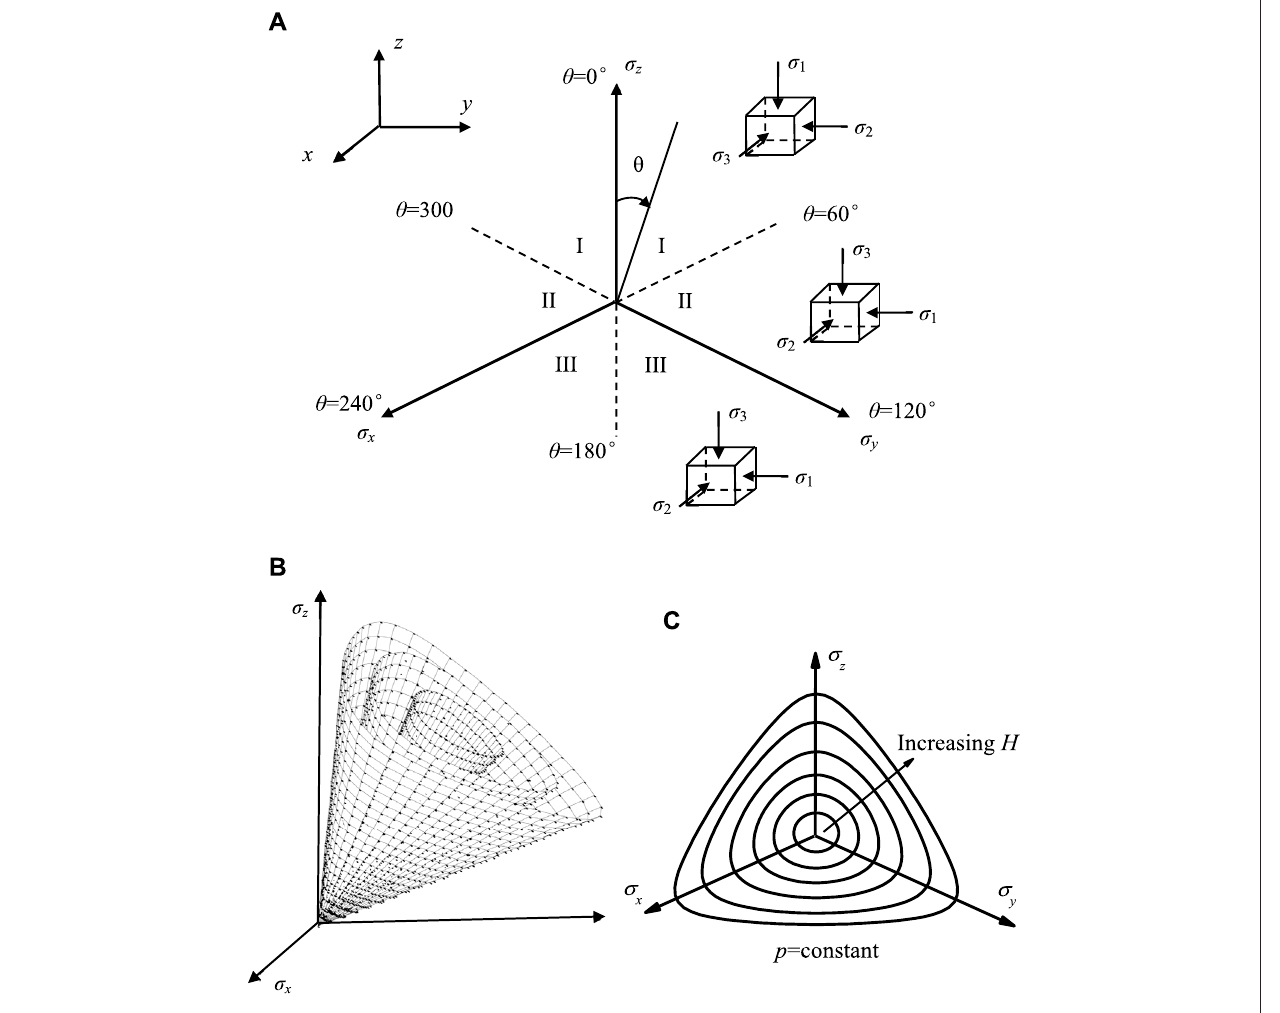
FIGURE 4 | (A) Angle θ de fi nitionand the deviatoric plane partition under the true triaxial test; (B) the yield surface in the 3D space and (C) the yield loci in the deviatoric plane.